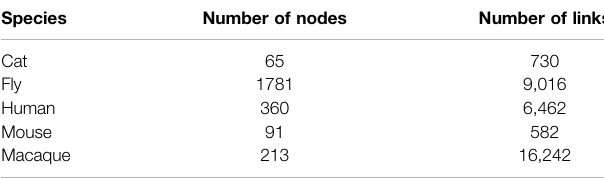
TABLE 1 | Overview of brain structure networks in different species.